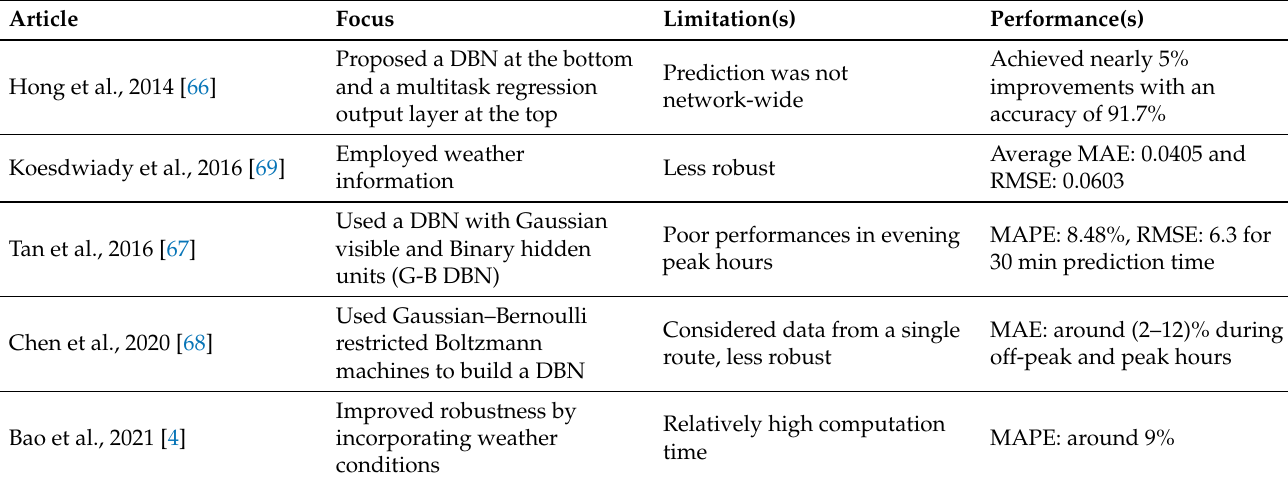
Table 9. Summary of the works found using